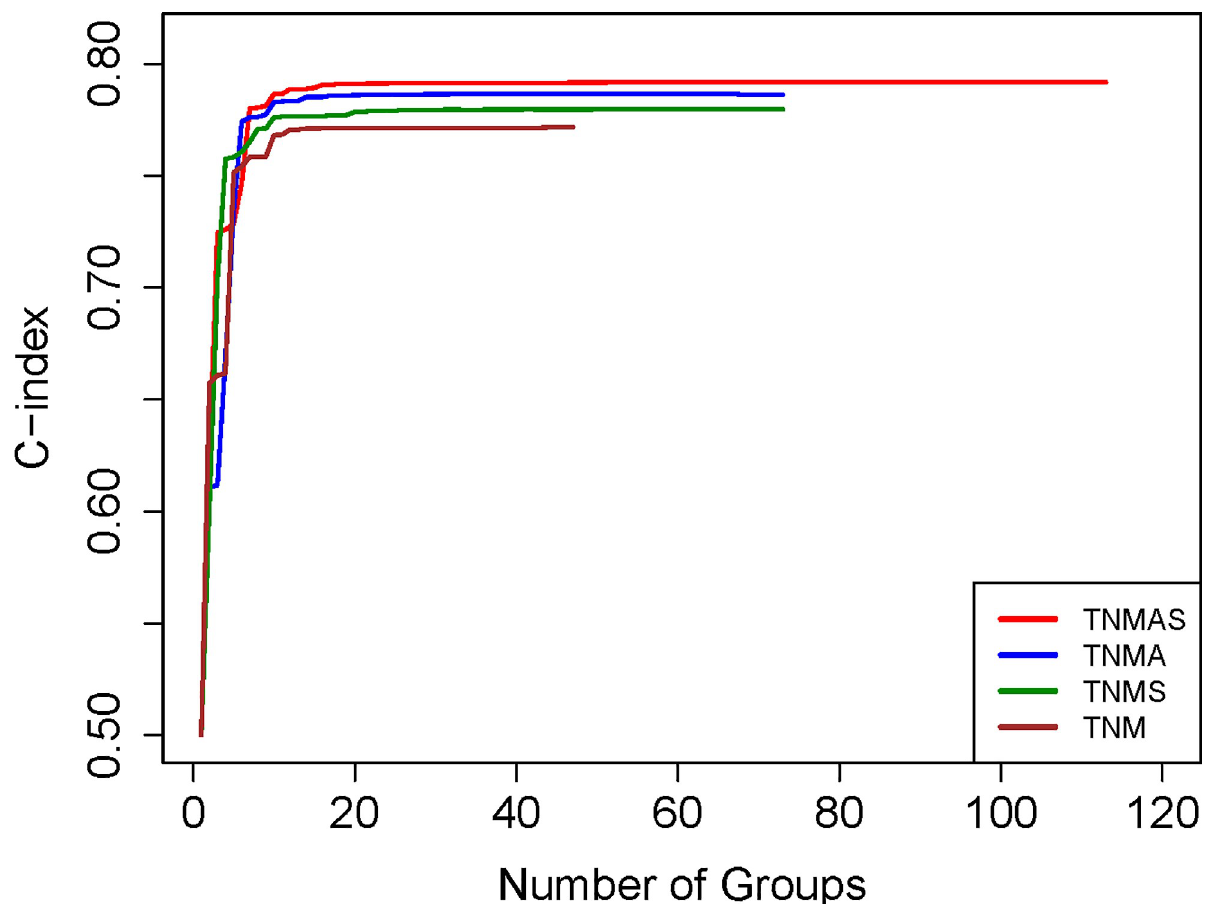
Fig 4. Training data C-index curves based on different factors.